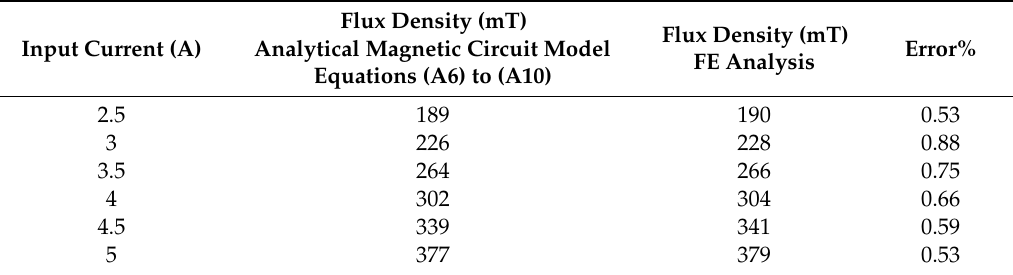
Table A2. Comparison of the flux density values at the center of the air gap of the